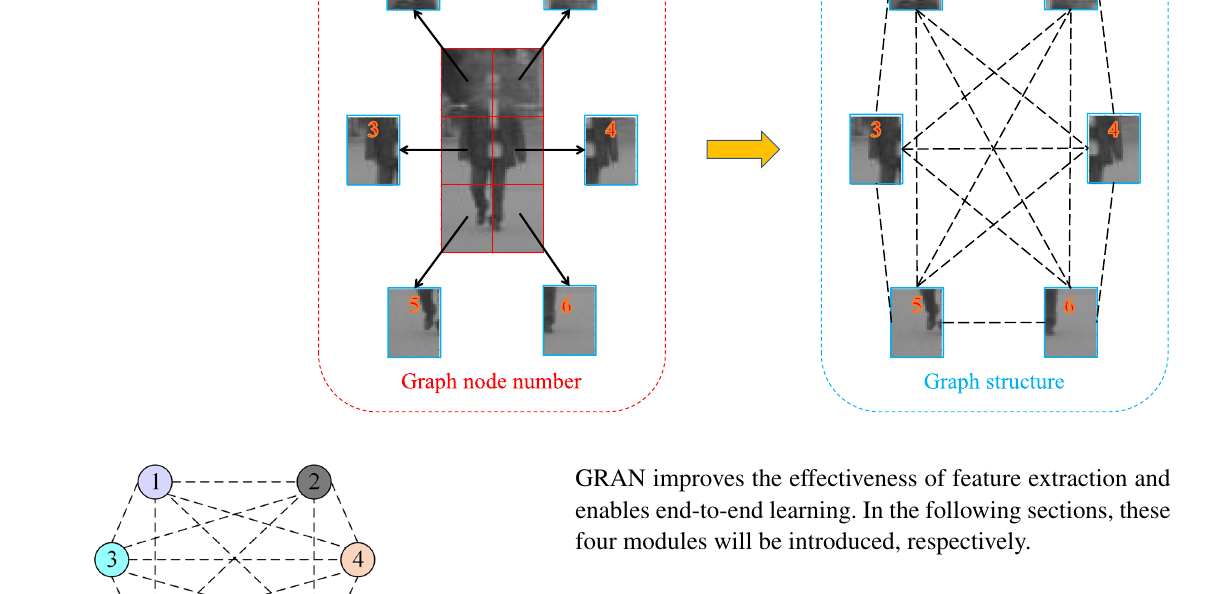
Fig. 3 Illustration of the graph node number and graph structure